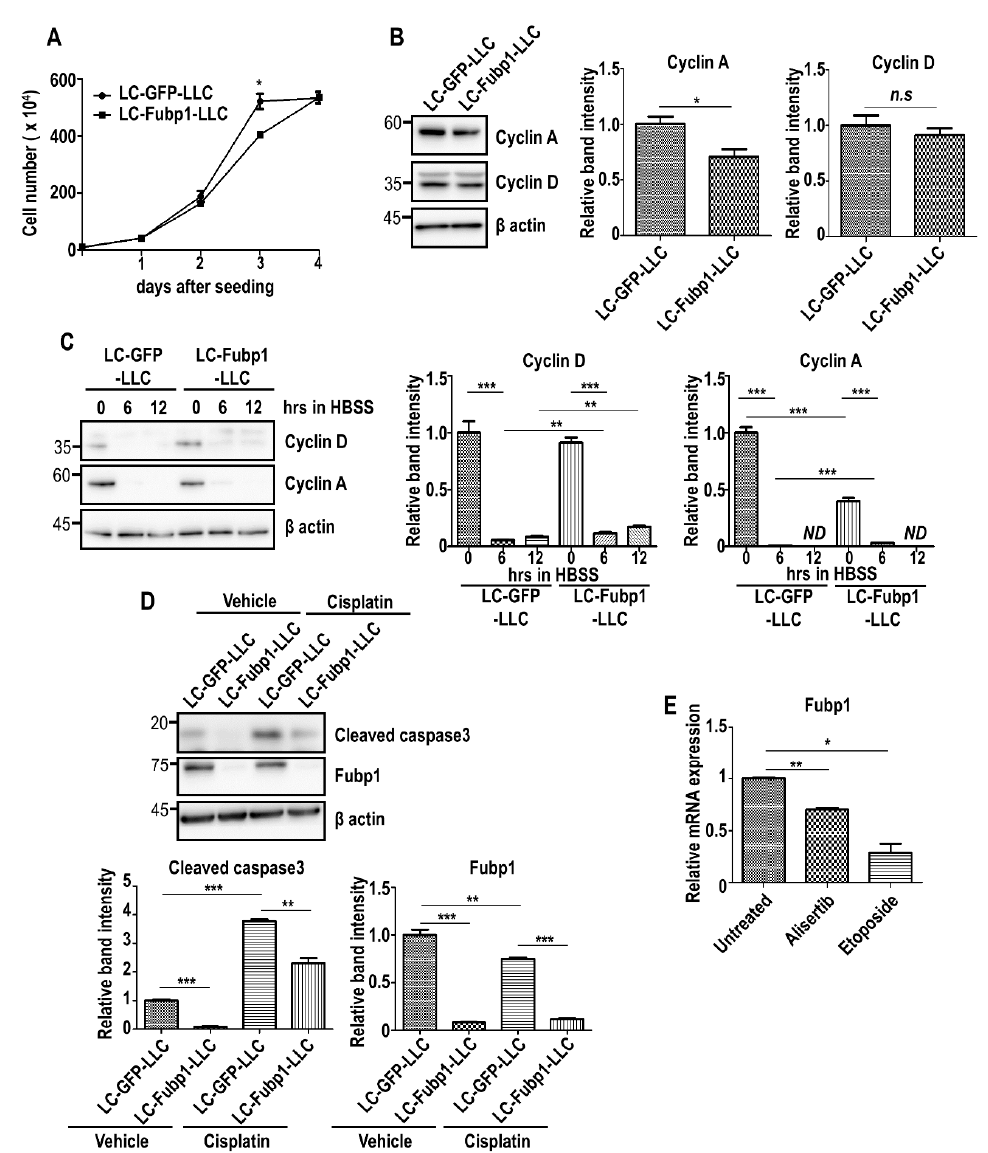
Figure 4. Multiple functions of Fubp1 in cell cycle progression and cell survival. ( A ) Measurement of total cell number in LC-GFP-LLC and LC-Fubp1-LLC cells. ( B ) Western blot analysis of the indicated proteins in control and Fubp1-deficient LLC cells. β actin was used as a loading control. The relative band intensities of cyclin A and cyclin D proteins are shown in the right panels. The intensities of LC-GFP-LLC cells were arbitrarily set as 1. ( C ) Western blot analysis of indicated proteins in control and Fubp1-deficient LLC cells incubated in HBSS for 6 h and 12 h. β actin was used as a loading control. The relative band intensities of cyclin A and cyclin D proteins are shown in the right panels. The intensities of LC-GFP-LLC cells at 0 h were arbitrarily set to 1. ( D ) Western blot analysis of the indicated proteins in control and Fubp1-deficient LLC cells treated with vehicle or cisplatin for 24 h. β actin was used as a loading control. The relative band intensities of cleaved caspase 3 and Fubp1 proteins are shown in the graphs below. The intensities of vehicle-treated LC-GFP-LLC cells were arbitrarily set to 1. ( E ) Comparison of Fubp1 mRNA expression in A549 lung cancer cells post treatment with anti-cancer drugs. Transcriptome data was derived from the NCBI GEO database (GEO accession: GSE102639). * p < 0.05, ** p < 0.01, *** p < 0.001, n.s.—not